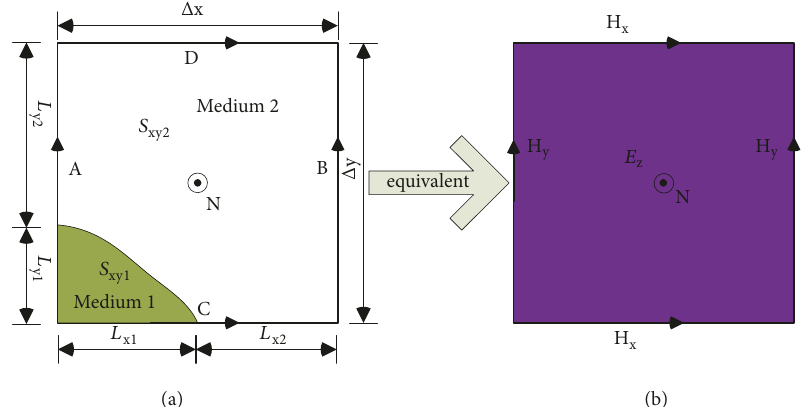
Figure 4: Schematic view for the equivalence of the medium parameters for a conformal grid point. (a) An actual subdivision grid. (b) A conformal